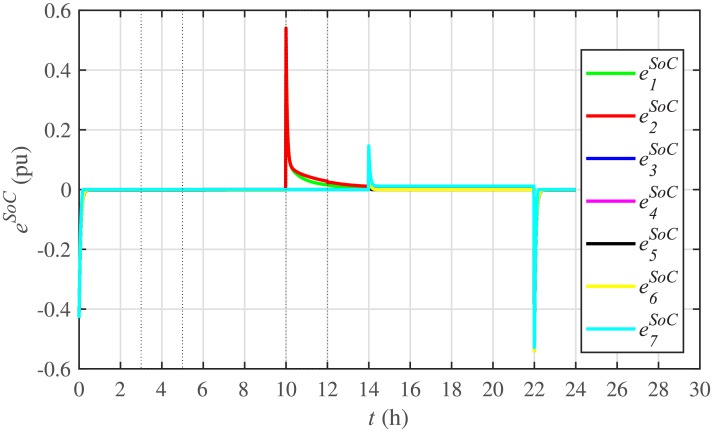
SoC tracking errors under case 6. [27].